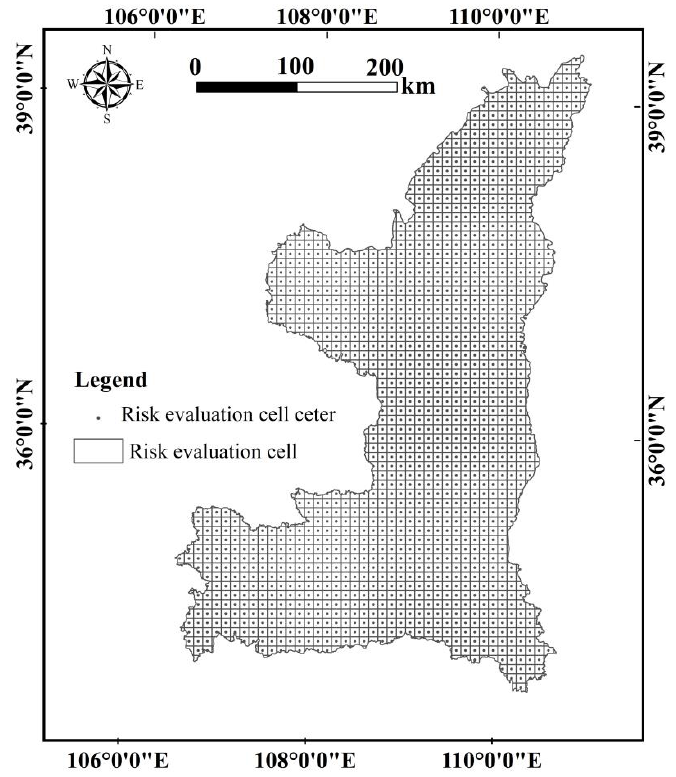
Figure 3. The ecological risk evaluation cells.